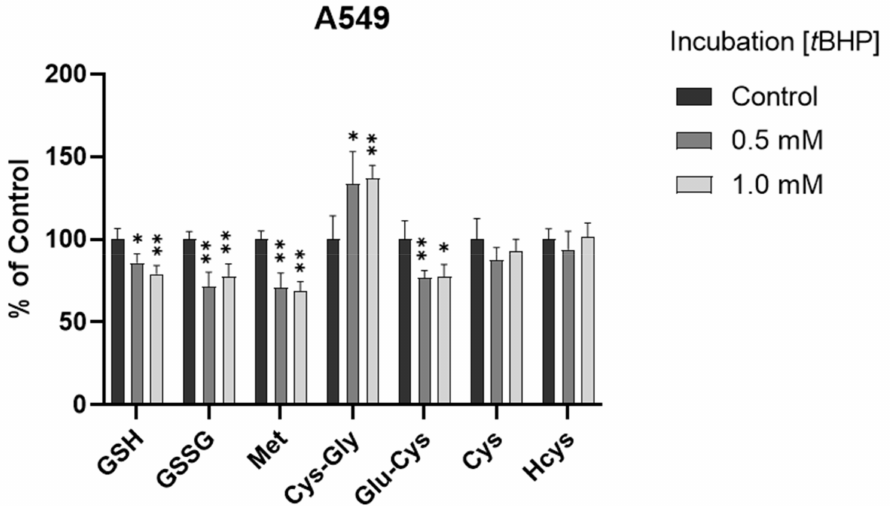
Figure 4. Alteration of analytes in A549 cells after 2 h t BHP treatment ( n = 6). The levels in treatment groups were normalized to those of the control group. *, p < 0.05; **, p <